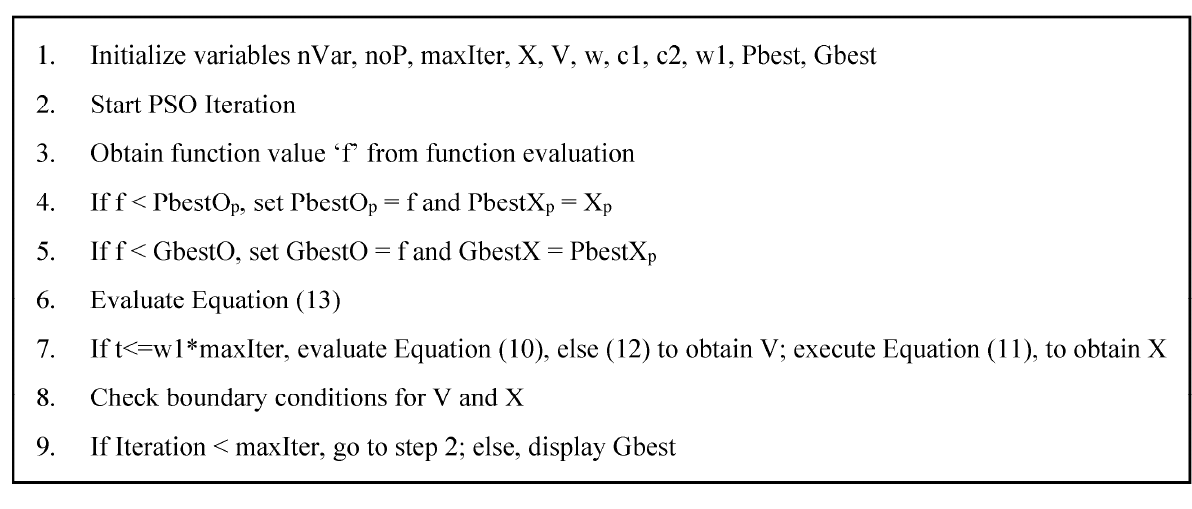
Figure 2. Pseudo code of proposed C-PSO.